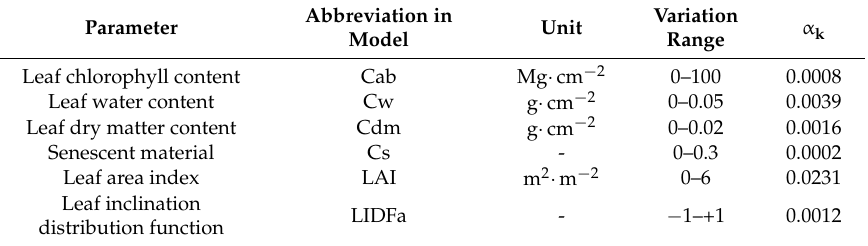
Table 4. Variation range of parameters for sensitivity analysis and the computed α k .